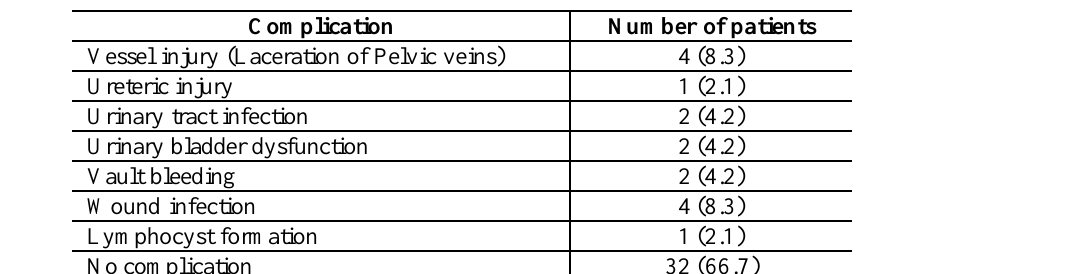
Table VI : Complications of radical